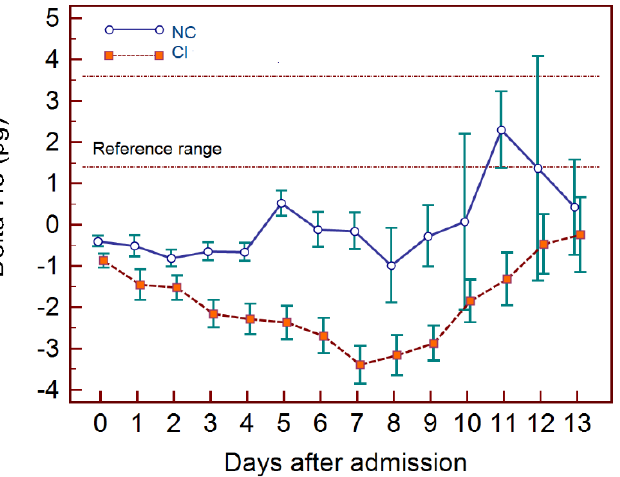
Figure 3. Example for Delta-He in a sepsis patient. The response to a change in antibiotic therapy is already apparent in the increase in Delta-He after 12 h—Other parameters respond much more slowly.